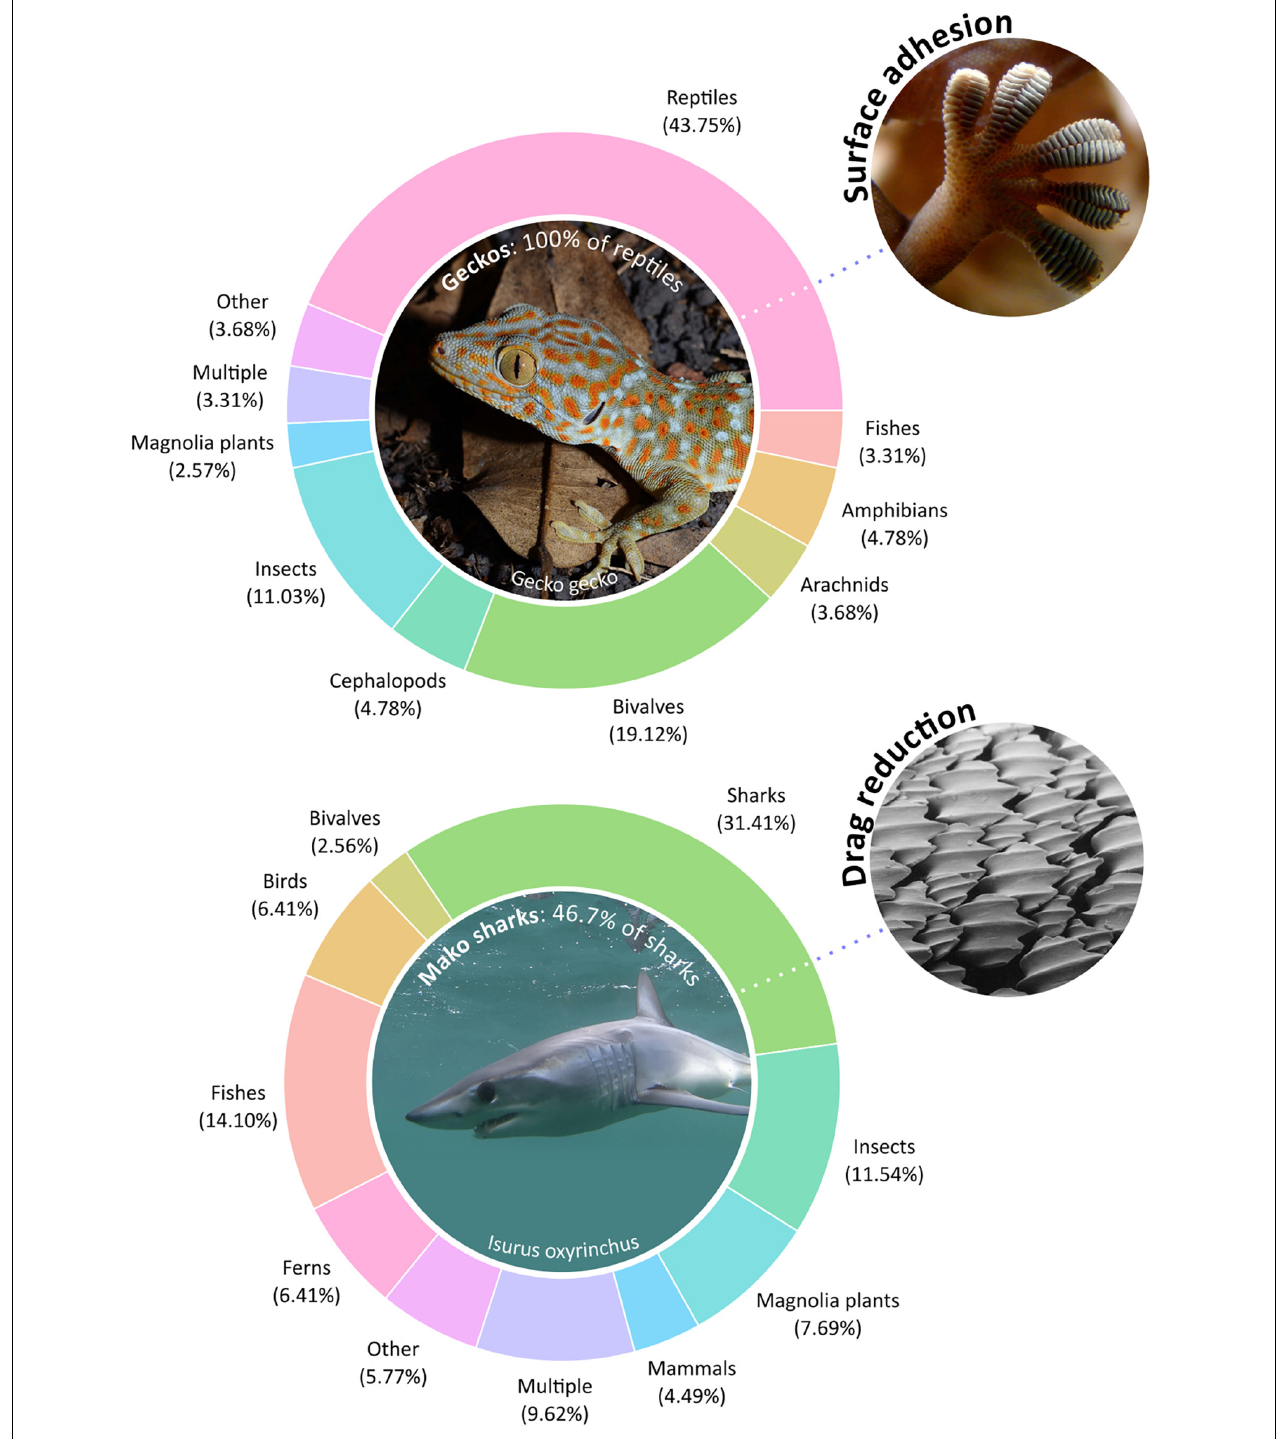
FIGURE 2 | Taxonomic distribution of surface adhesion and drag reduction research. We identified 156 papers for drag reduction and 272 papers for surface adhesion. Percentages are the percentage of the identified papers focusing on each taxon. “Multiple” indicates research including multiple focal species, while “Other” indicates the sum of genera with less than 4% representation. Most of the research is concentrated in a select few model species despite the biological diversity from which insights can be potentially drawn. Only few studies involve multiple species and instead focus on a single model. Original photos by Patrick Randall (gecko), Bjørn Tørrissen (gecko foot), Elaine Brewer (shark), and Pascal Deynat (shark skin).